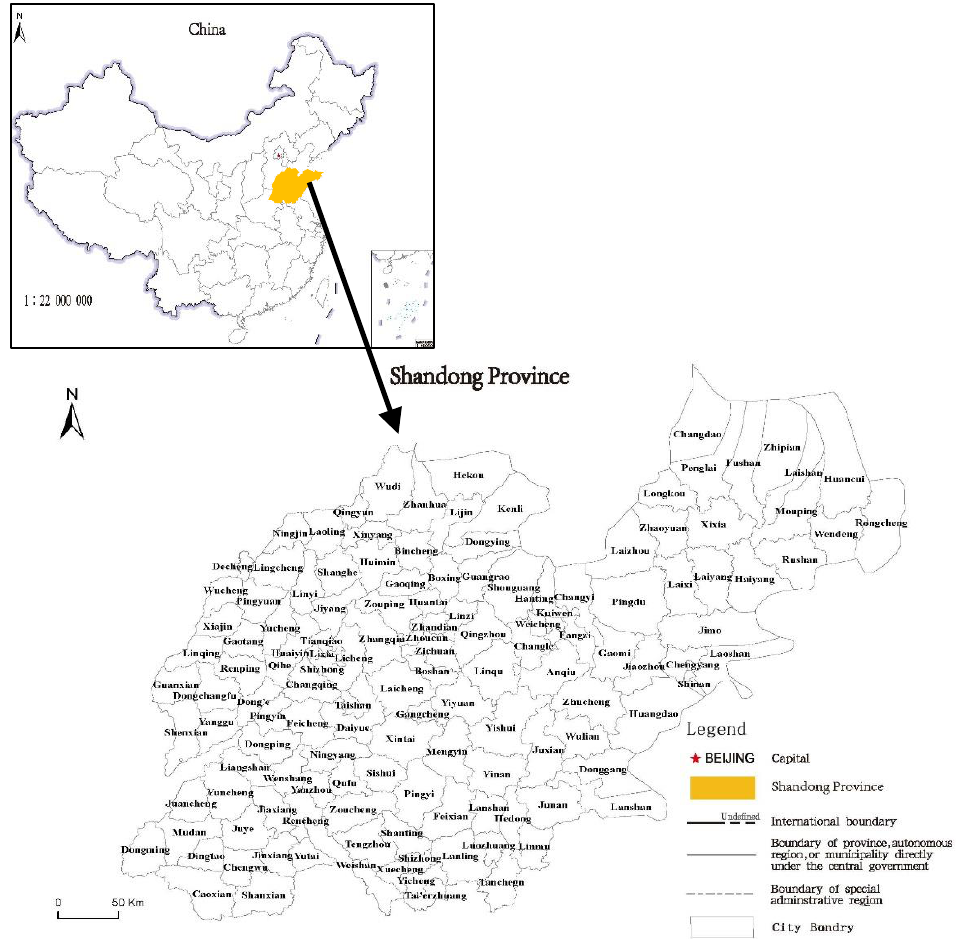
Figure 1. The location of the study area in China.